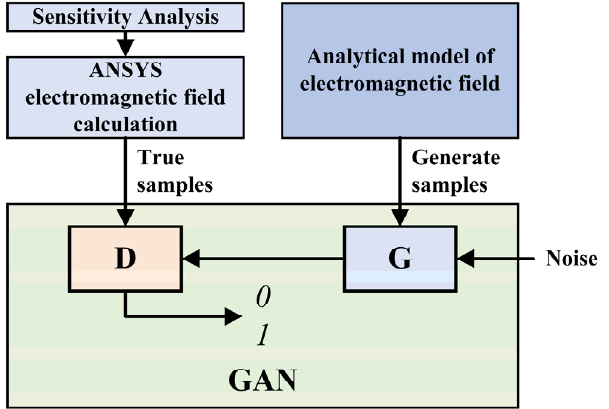
Figure 6. Basic structure of GAN.